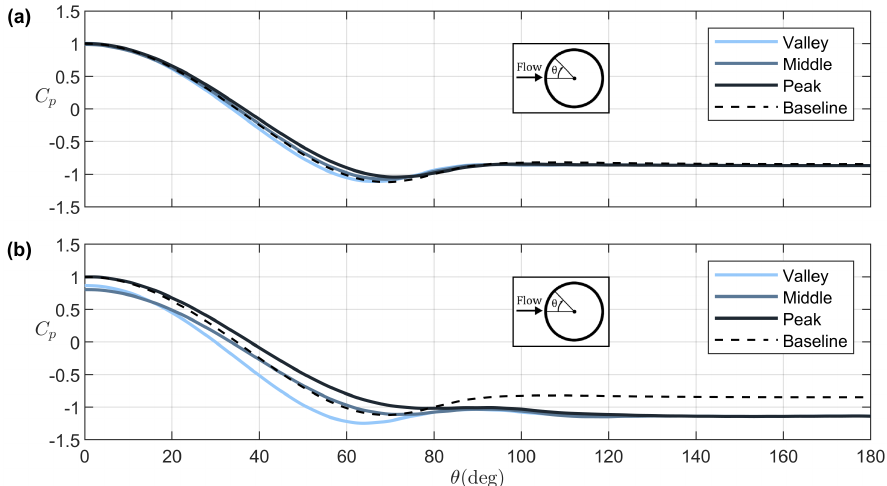
Figure 10. Sectional mean C p distributions for A03 ( a ) and A11 ( b ). A dashed curve denotes the baseline C p